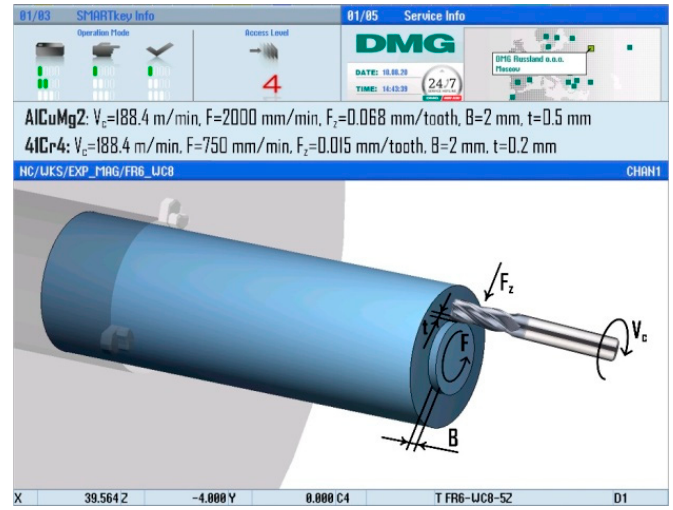
Figure 3. Processing strategy and cutting conditions for machining AlCuMg2 and 41Cr4 steel Figure3. ProcessingstrategyandcuttingconditionsformachiningAlCuMg2and41Cr4steelworkpieces workpieces with end mills. with end